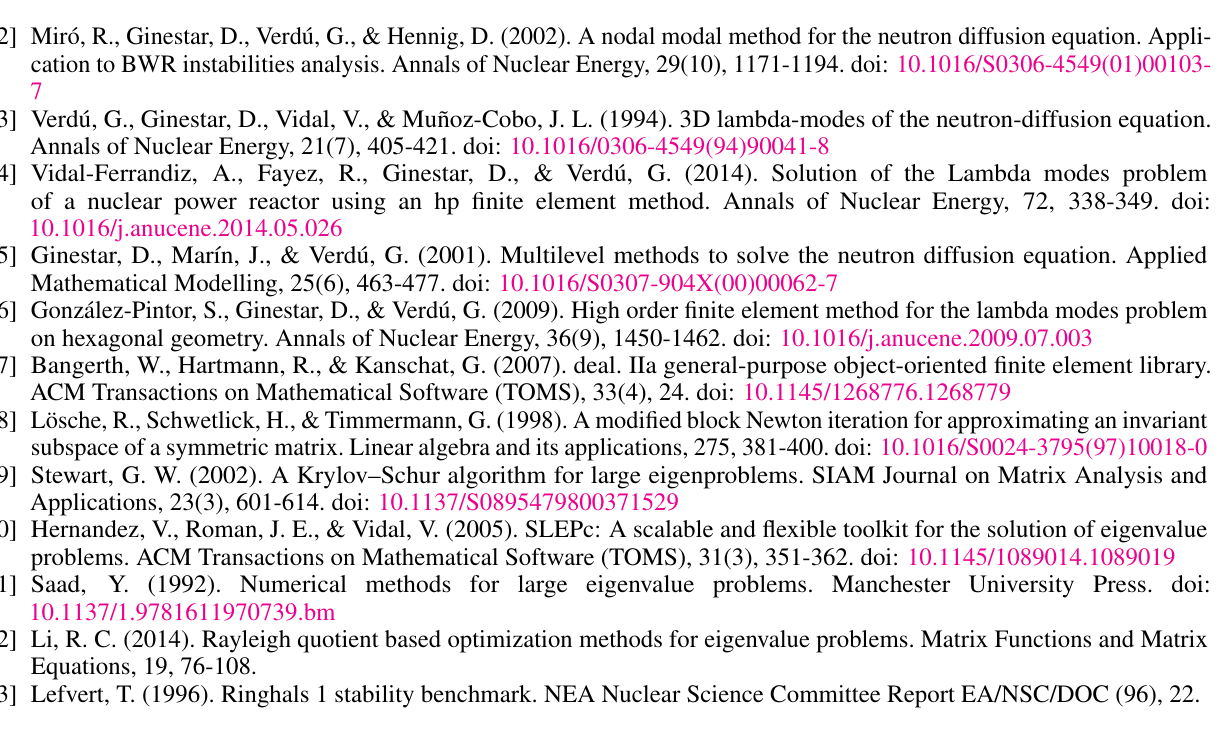
Fig. 5 CPU time of multilevel method for Ringhals reactor with FED =